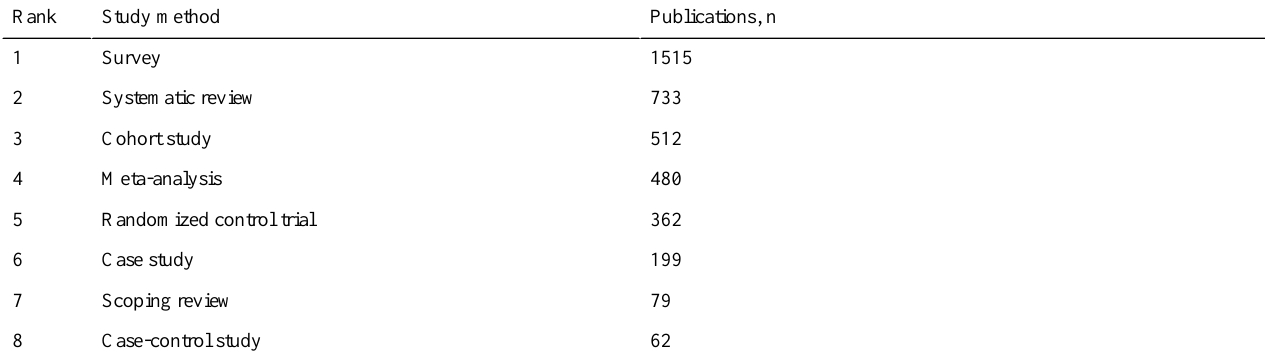
Table 4. Eight most common study methods extracted from the publications mentioning the study design used in the